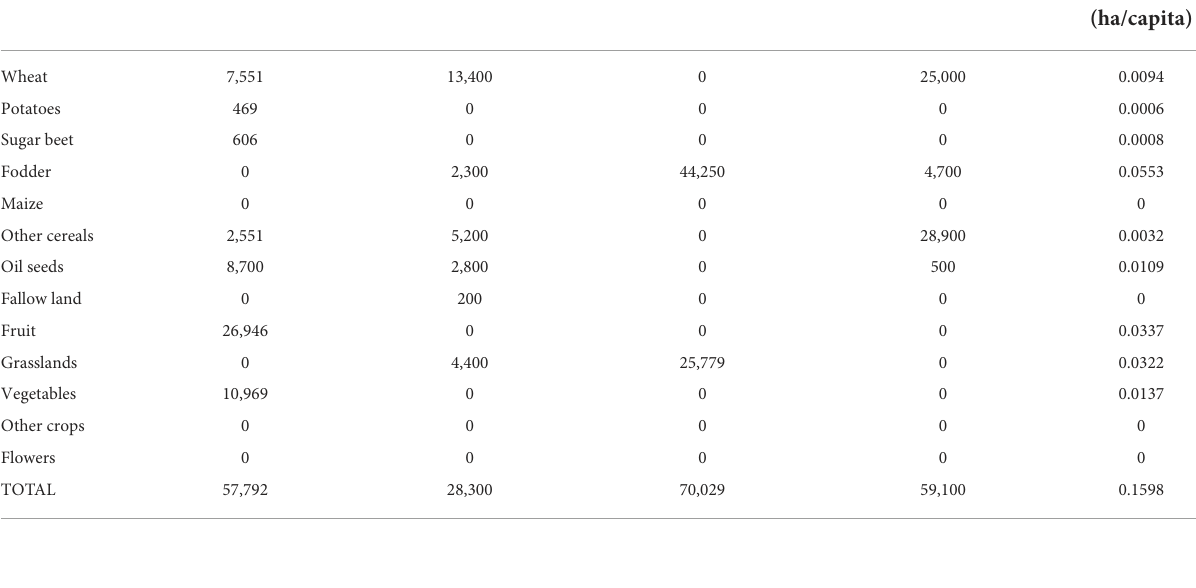
TABLE 3 Food demand and supply for Copenhagen: EAT-Lancet scenario (in hectares). Food group Demand plant-based Supply plant-based Demand animal-based Supply animal-based Area demand